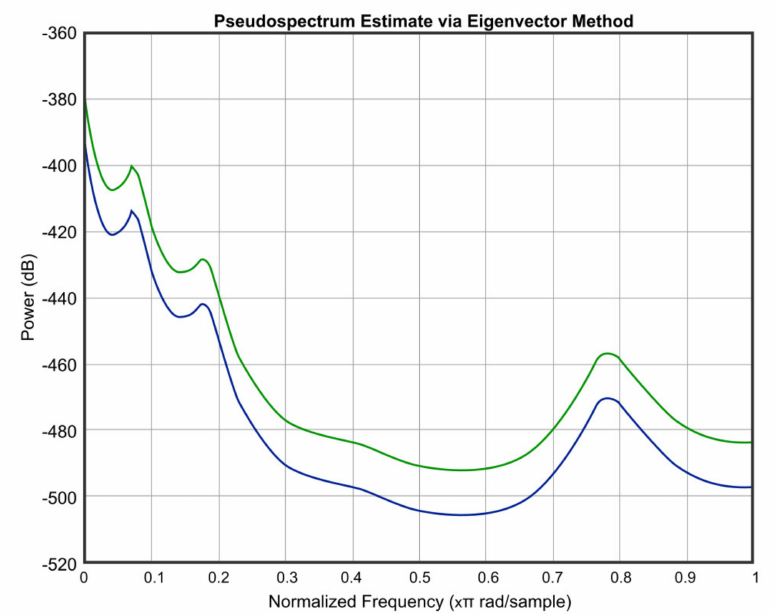
Figure 16. Signal behavior at T = 0 ◦ C and RH = 0% (blue) compared to T = 36 ◦ C and RH = 40% (green).